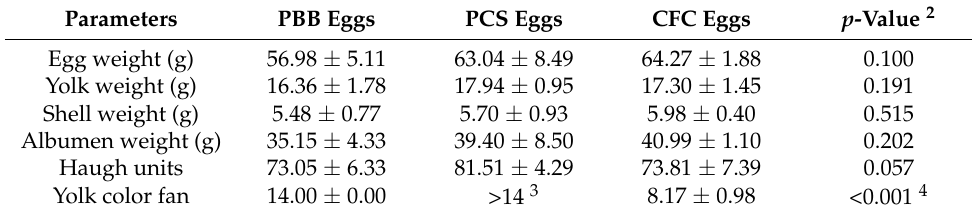
Table 3. Physical characteristics of the eggs 1 .